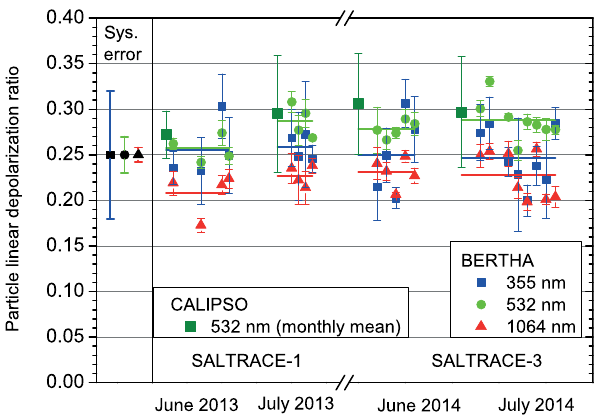
Figure 13. Overview of SAL layer mean particle depolarization ra- tios measured with triple-wavelength polarization lidar BERTHA during SALTRACE-1 (2013) and SALTRACE-3 (2014). Only triple-wavelength observations (one per evening) are considered. Horizontal lines show the mean values of all measurements con- ducted in 1 of the 4 SALTRACE months in 2013 and 2014. Er- ror bars indicated the standard deviation calculated from all depo- larization values (available with 50m vertical resolution) between SAL base and top. Respective CALIOP monthly mean values and standard deviations of the SAL column particle depolarization ra- tios at 532nm are shown for comparison. Level 2 version 3.30 CALIPSO aerosol profile data around Barbados are used for this retrieval (CALIPSO, 2016). The systematic error bars shown on the left-hand side illustrate the impact of all the retrieval uncertainties on the